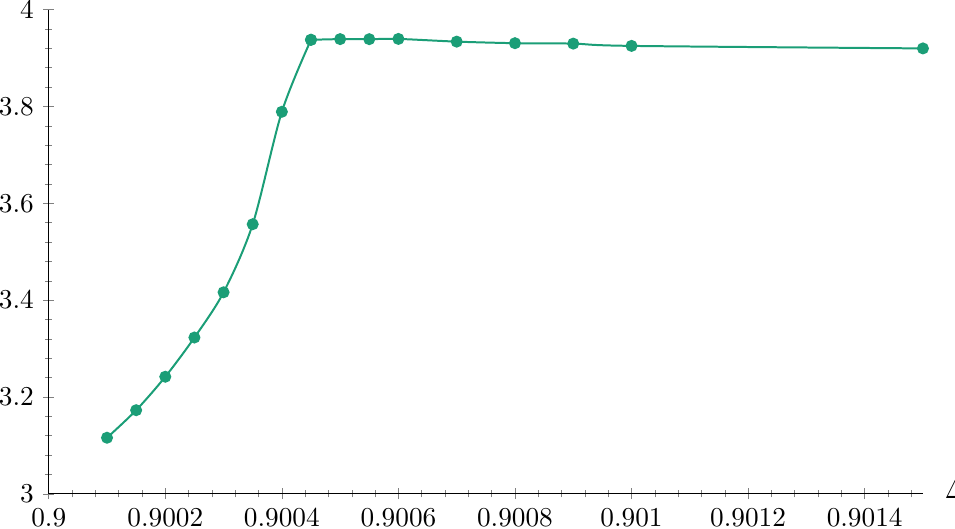
at the C b solution in d = 3 : 8, i.e. assuming that (cid:1) V 3 (cid:3)